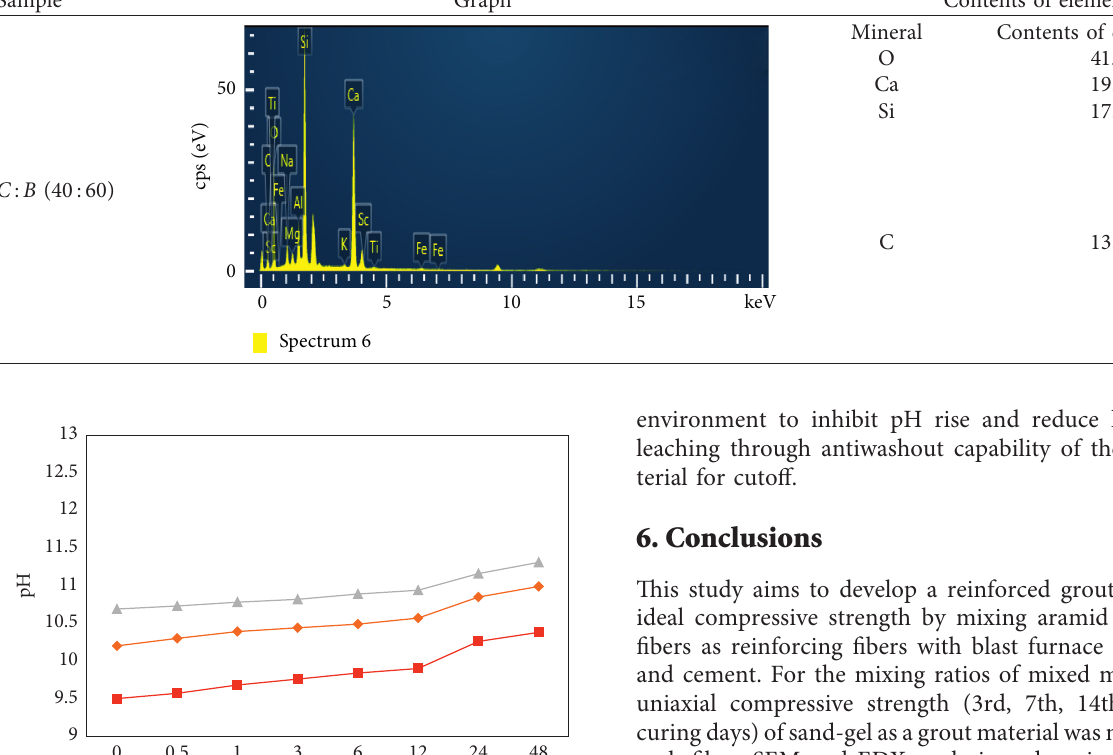
Table 7: Findings from EDX analysis for C : B of 40: 60%. Sample